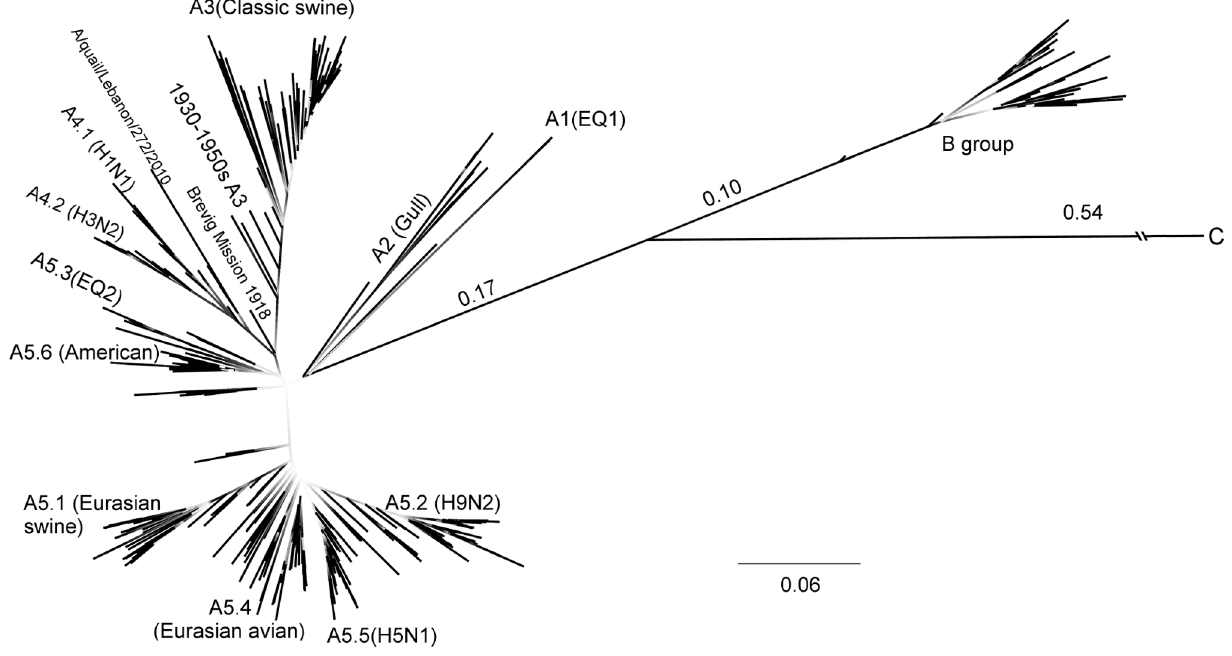
Figure 1. Maximum likelihood phylogenetic reconstruction of NS1-coding RNA sequences using db415 (415 cluster-representative sequences). A GTR + I + C 4 model was used to estimate evolutionary rate differences among sites with a bootstrap value of 500. The tree with the highest likelihood was visualized using FigTree 1.3.1 (http://tree.bio.ed.ac.uk/software/figtree/). Darker and thicker lines correlate with higher bootstrap values in branches ( . 50%). Nodes with the lowest bootstrap values (0.1 or less) were intentionally left white to emphasize uncertainty. The H1N1 A/Brevig Mission/1918 sequence fitted closer to the (A3, A4) node. A1 (EQ1) and A2 (Gull) share many sequence features with A5 (Avian) , but their long branches and distances (Table 2) granted them recognition as different A subtypes.